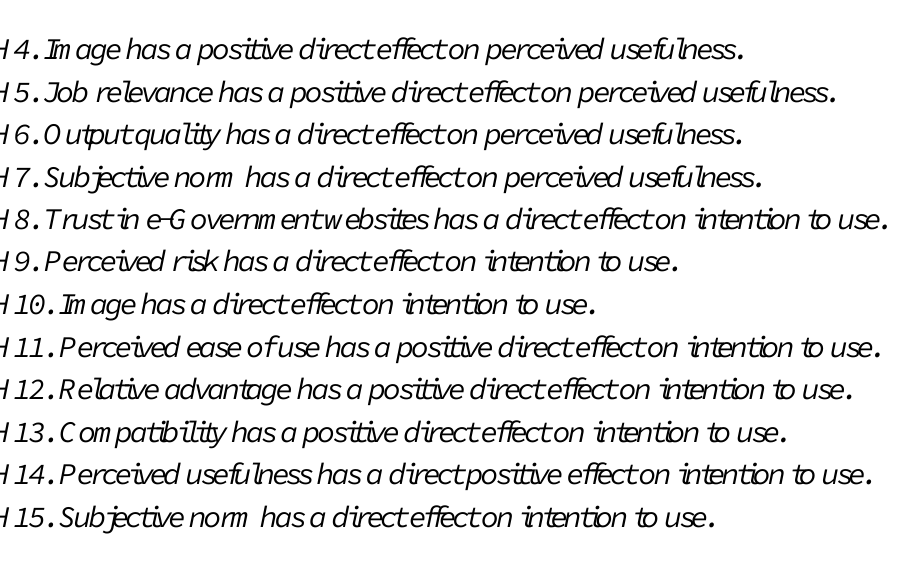
Figure 1. The research model after